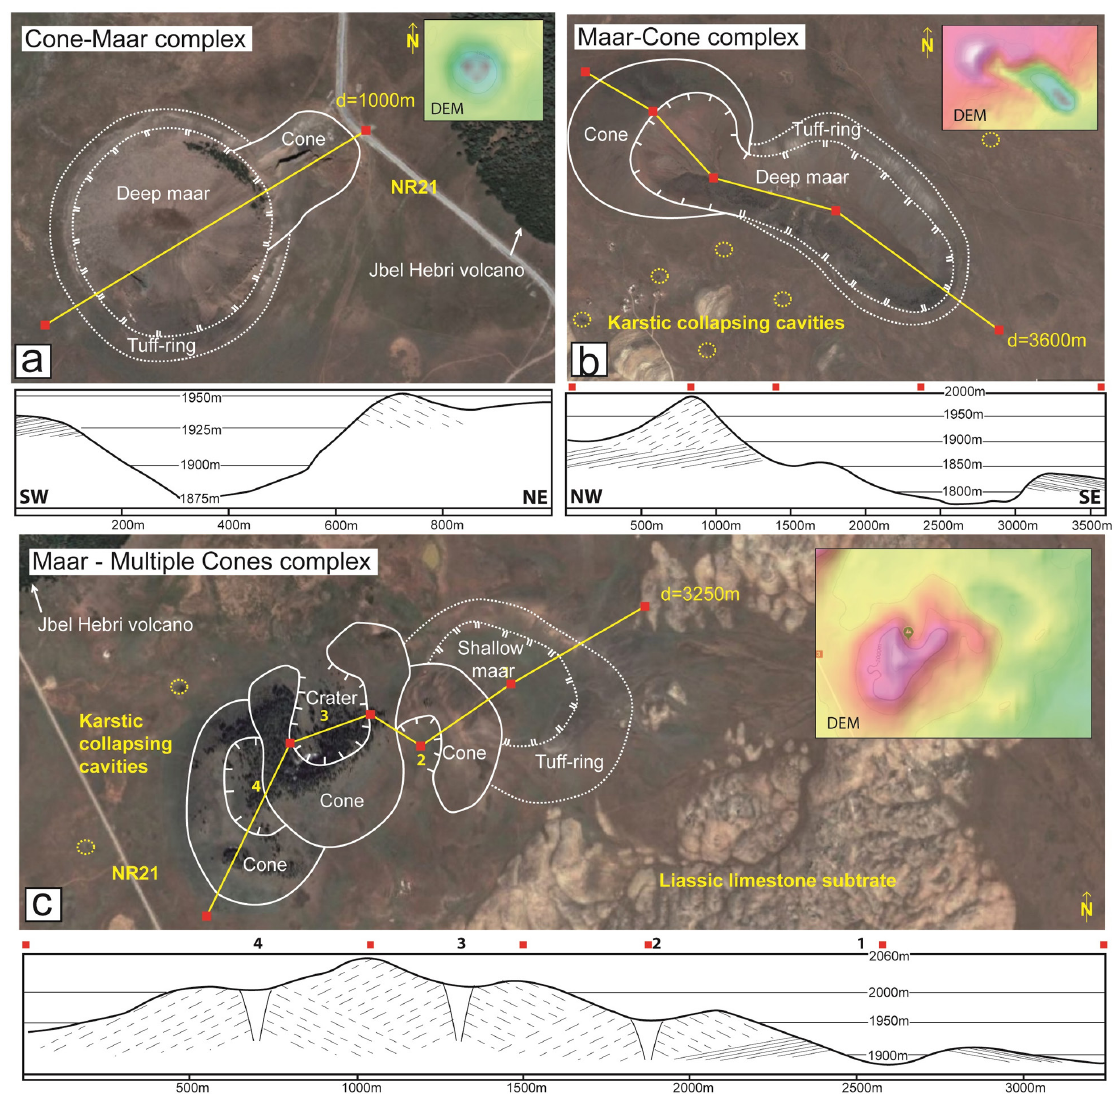
Fig. 8. Morphology, shape, and crater outline of cone-maar mixes sketched on Google satellite images jointed to the digital elevation model overview the cross-section sketch. DEM – Digital Elevation Model; NR21 – national roadway no.